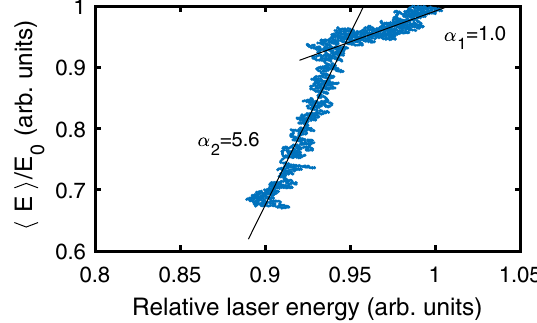
FIG. 5. Correlation between the electron mean energy and the relative laser energy right before the off-axis focusing parabola, and linear fits of the two different parts of the curve, with slopes α α 1 and 2